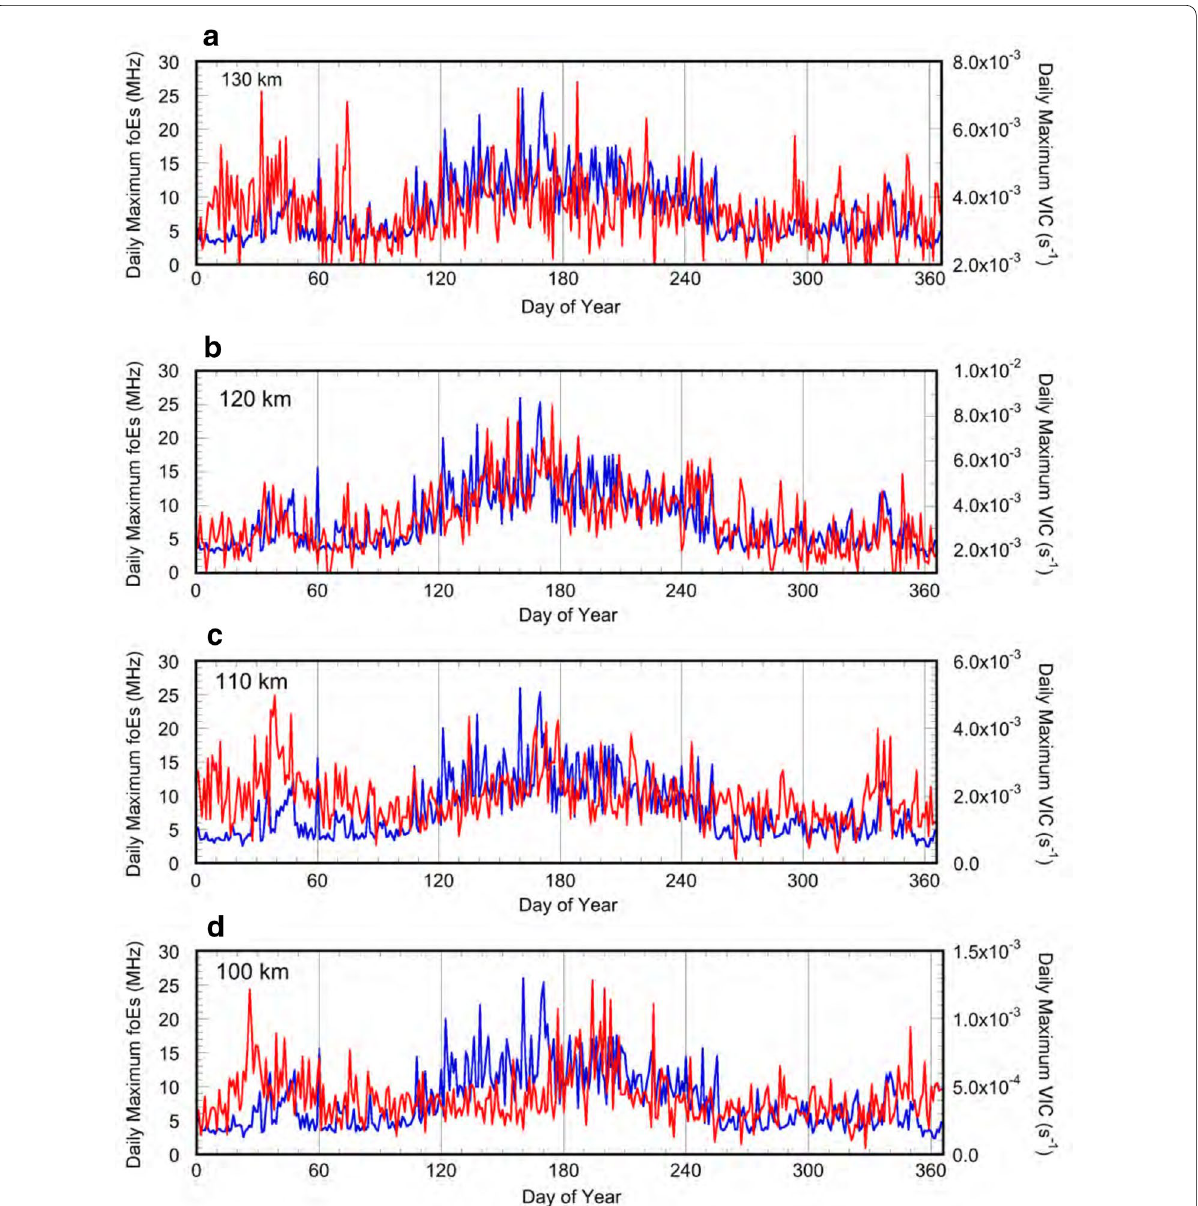
Fig. 6 Daily maximums of foEs and daily maximums of VIC . The daily maximums of foEs (blue line) and the daily maximums of the vertical ion convergence ( VIC ) are compared at four different altitudes (red line) in 2009 at